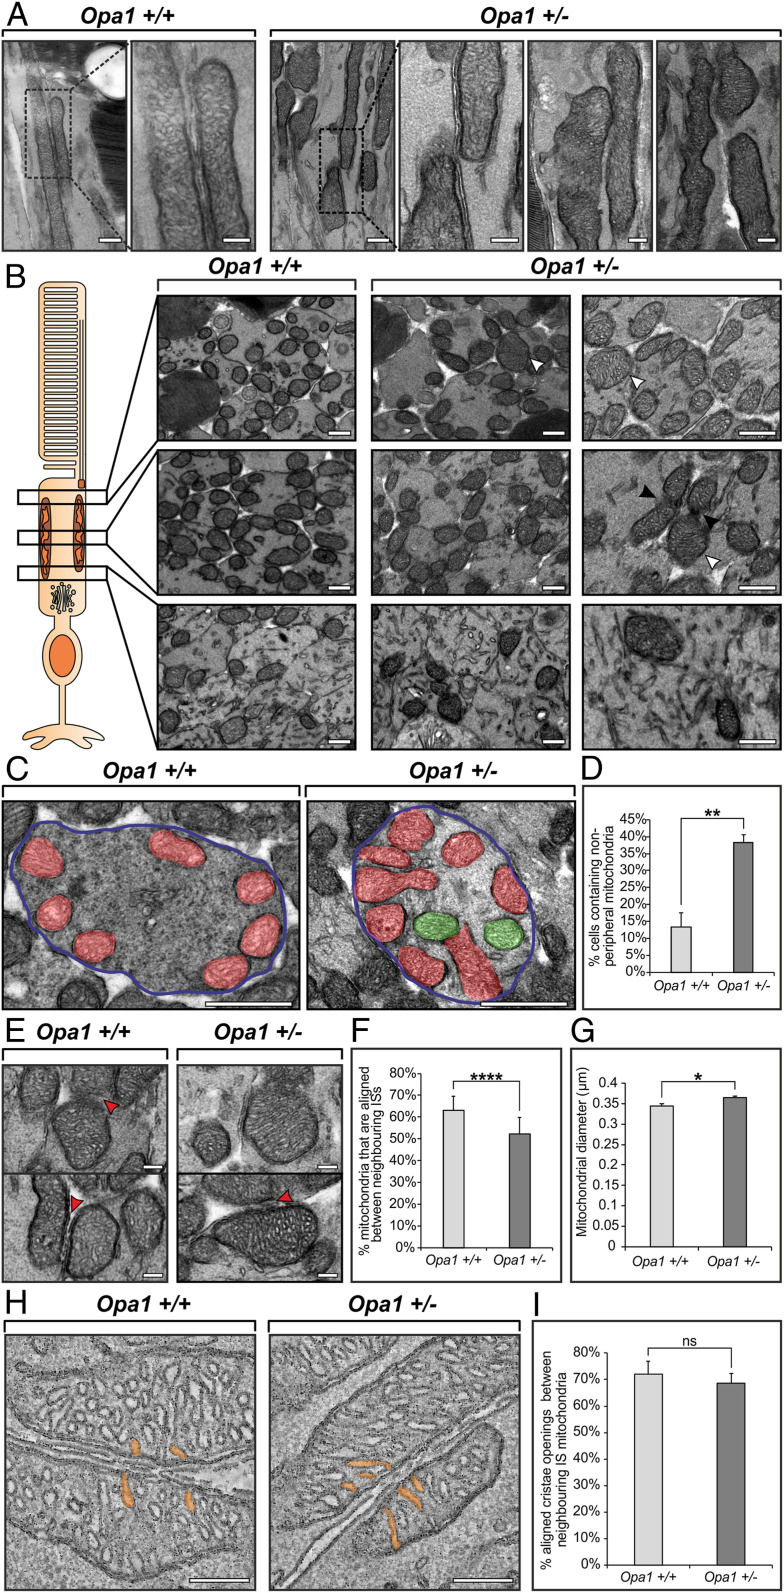
Heterozygous KO of Opa1 leads to changes in the mitochondria morphology and positioning, but not the alignment of cristae openings. (A) TEM images of longitudinally orientated retina from Opa1+/+ and Opa1+/− mice. The boxed areas are shown at higher magnification in the panels on the right. (B) Cross-sectionally-orientated retina examined at different regions of the IS indicate enlarged mitochondria (white arrowheads) and evidence of a mitochondrial fusion defect (black arrowheads). (C) IS cross-sections in which mitochondria against the PM are false colored in red, and those away from the PM are in green. (D) An increase in the number of ISs that have mitochondria positioned away from the PM in the Opa1+/− (average = three eyes). (E) Images showing larger mitochondria in the Opa1+/− mice ISs, but no obvious morphological defects of the cristae. The red arrowheads indicate where there are mitochondria aligned between neighbouring ISs. (F) A reduced number of mitochondria are aligned between neighboring ISs (average = 15 regions with ≥127 mitochondria from three eyes). (G) Measurements of mitochondria show an increase in the average diameter in the Opa1+/− mice (average = 300 mitochondria from three eyes). (H and I) Tomographic slices show the presence of cristae opening alignment in the both the Opa1+/+ and Opa1+/− mice, and measurement show no significant difference between the two mouse models (average = three tomograms). (E–G) Data are mean ± SE. *P < 0.05; **P < 0.01; ****P < 0.0001; ns, not significant (determined by Student's t test). (Scale bars: 200 nm [A], 500 nm [B], 1 µm [C], and 200 nm [E and H]).